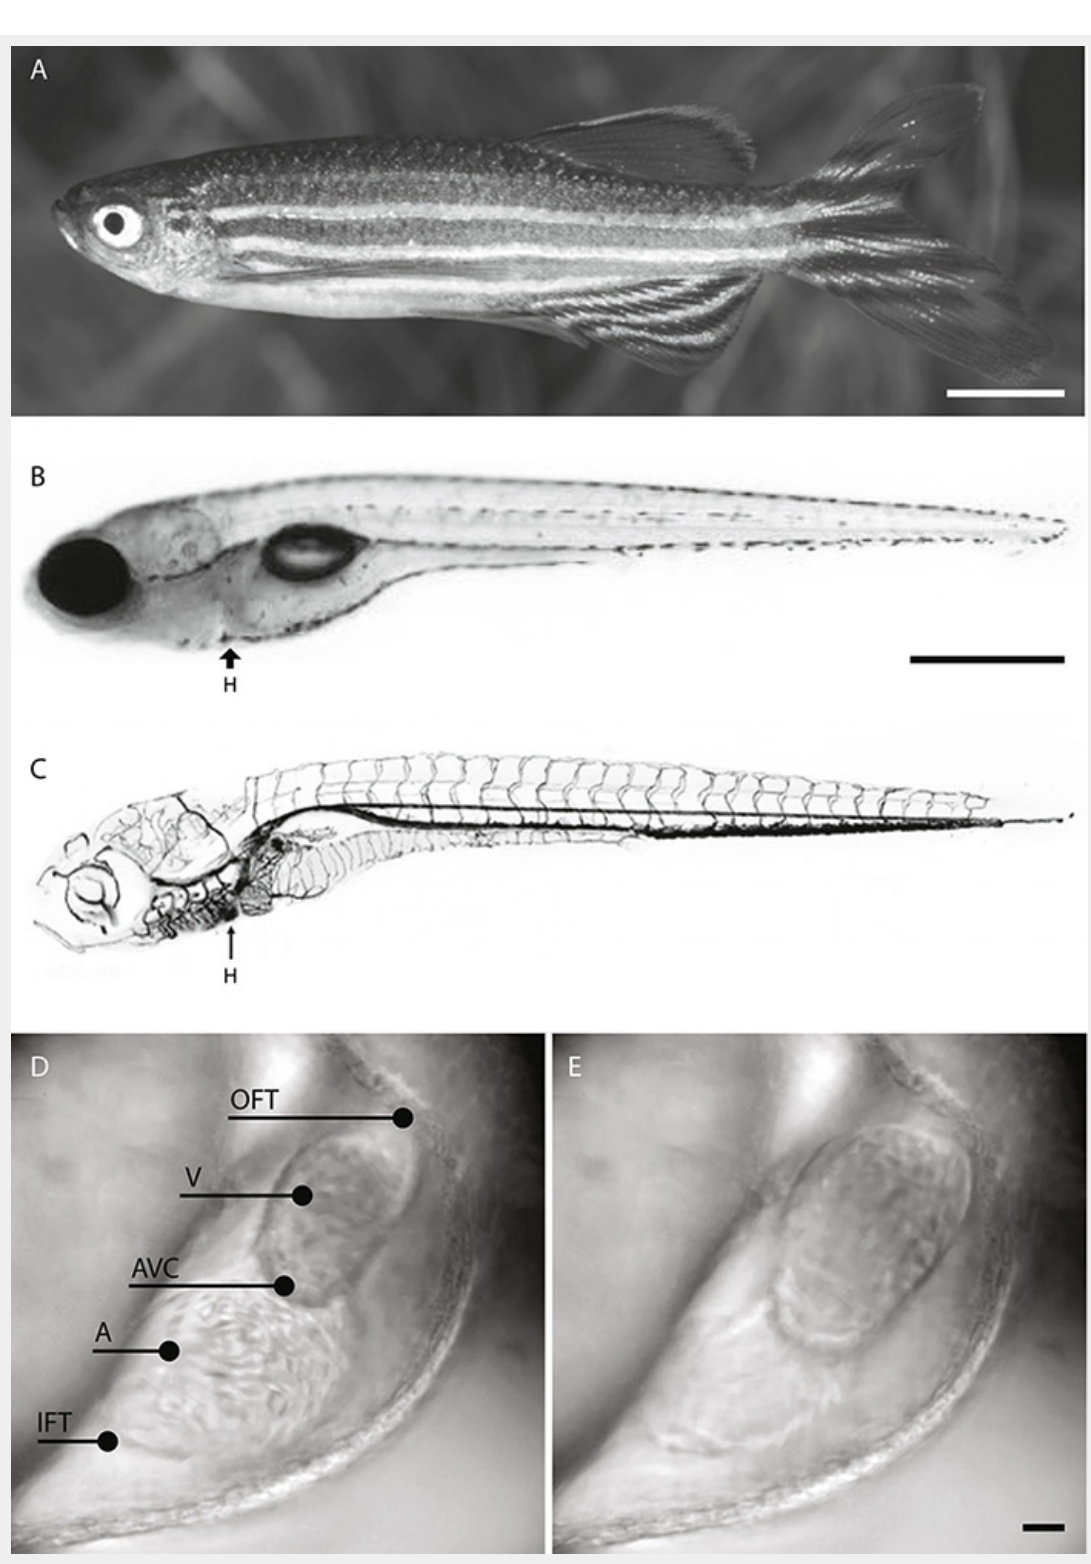
Figure 1 A: Adult male zebrafish. Scale bar 5 mm. B: Bright-field image of a 7 dpf (days post-fertilisation) zebrafish larva. Scale bar: 500 µm. C: The position of the heart (H) in the cardiovascular system of a zebrafish larva. Images adapted from Brown University (Isogai et al. 2001 [66]) and Interactive Atlas of Zebrafish Vascular Anatomy (zfish.nichd.nih.gov). D–E: Bright-field images of the 2 dpf zebrafish heart. D: Systole. E: Diastole. Inflow tract (IFT), atrium (A), atrioventricular canal (AVC), ventricle (V), outflow tract (OFT). Scale bar: 20